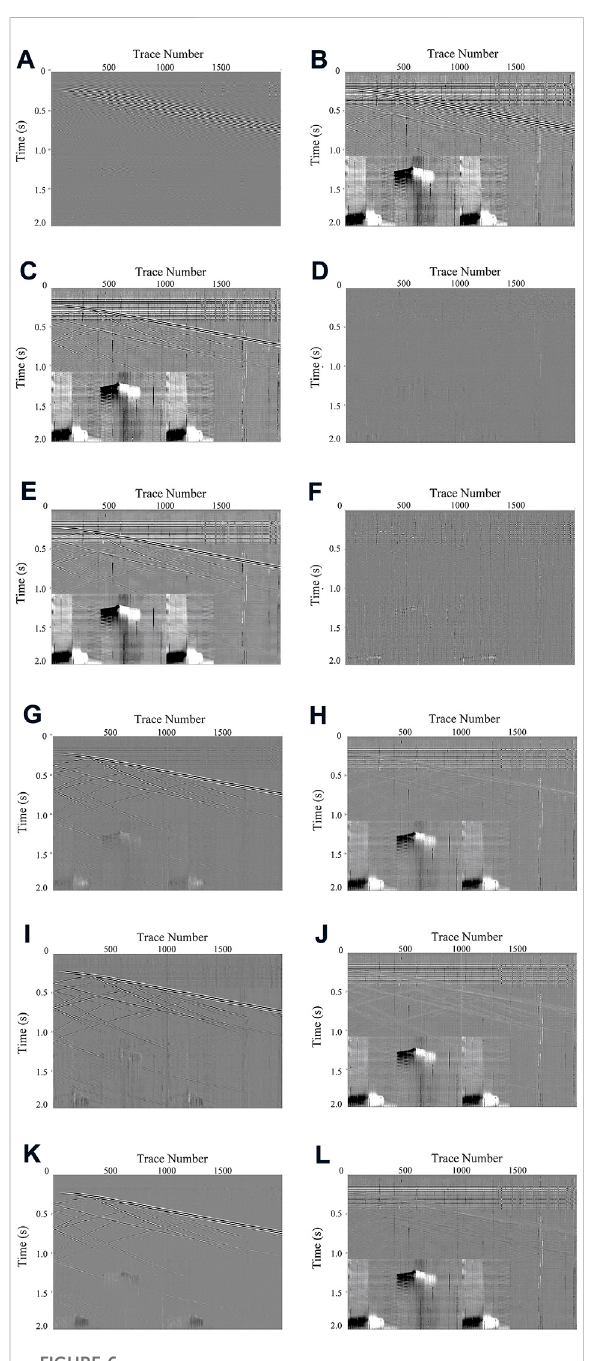
FIGURE 6 Comparisons for denoising results of different methods. (A – B) The denoising result with the SNR of 1.9371 dB and predicted noise of Band-pass fi ltering. (C – D) The denoising result with the SNR of 1.0421 dB and predicted noise of Wavelet transform fi ltering. (E – F) The denoising result with the SNR of 0.5712 dB and predicted noise of WNNM. (G – H) The denoising result with the SNR of 18.3209 dB and predicted noise of DnCNN. (I – J) The denoising result with the SNR of 18.4935 dB and predicted noise of U-Net (K – L) The denoising result with the SNR of 19.0062 dB and predicted noise of